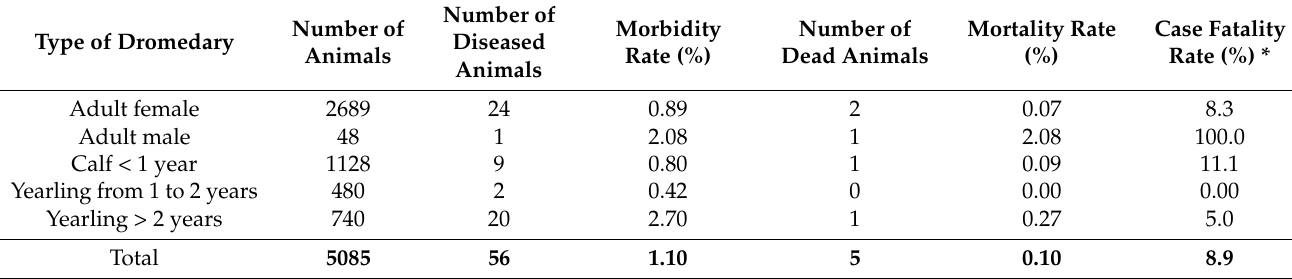
Table 1. Number of different types of dromedaries affected by camelpox disease at unit 1 of EICMP. Type of